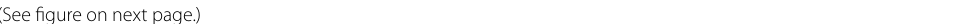
figure on next Fig. 3 a Images of the bending process in the magnetic field of the ferrogel (Reproduced with permission from Ref. [45], © 2009, Inc. J Appl Polym Sci, Wiley Periodicals). b A cantilever actuator made of magnetic hydrogel (left) and its demonstration of the magnetic responses with 20% IONPs content (right). (Reproduced with permission from Ref. [37], © 2015, The Royal Society of Chemistry). c Schematic of the crawling motion of the hydrogel actuator under the AMF, similar to that of maggots. (Reproduced with permission from Ref. [46], © 2017, The Authors; published by Springer Nature). d Demonstration of the magnetic actuator showing sequential movement of the microlooper. The movement of the magnetic actuator possesses two different magnetic axes. Therefore, it actuates in a zigzag conformation when the magnetic field is applied. It is synthesized with PEGDA hydrogel. (Reproduced with permission from Ref. [38], © 2011, Macmillan Publishers Limited). e Schematic of the synthesizing method of the biomimetic soft micromachines with photo-patterning fabrication (left). The image also shows the optical image with different types of complex micromachines driven by the rotating uniform magnetic fields. (Reproduced with permission from Ref. [47], © 2016, Nature Publishing